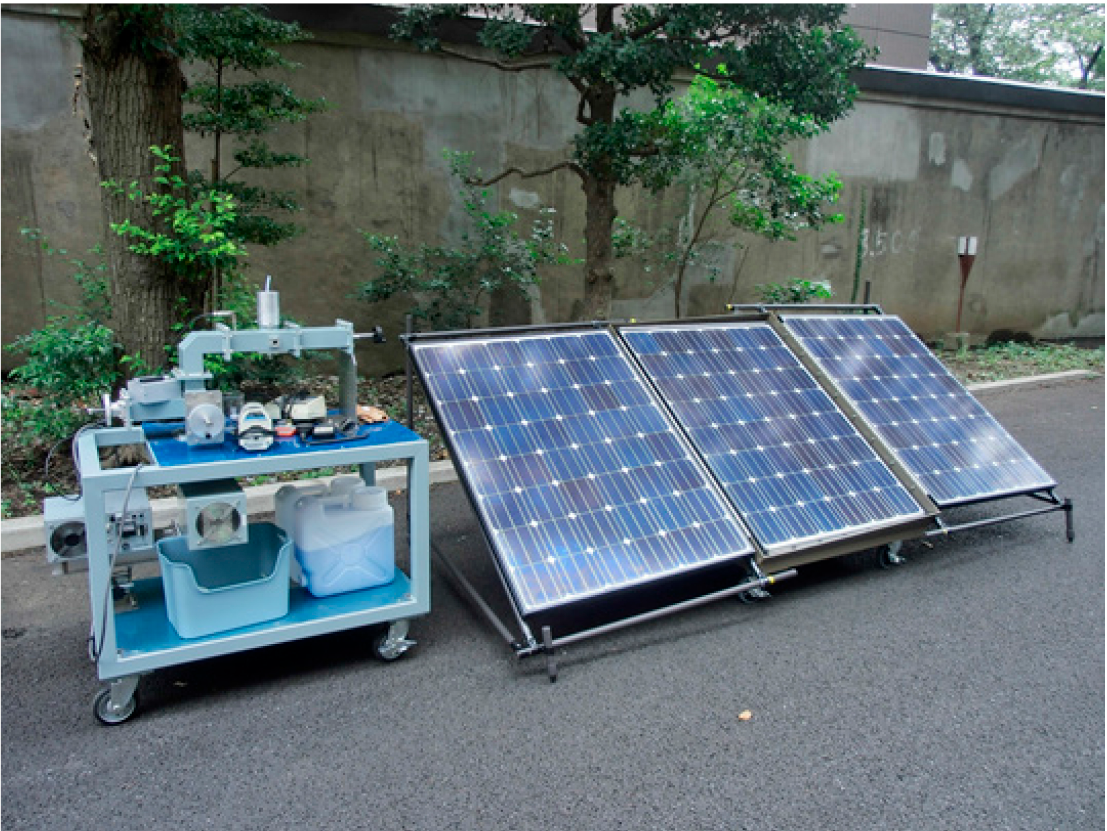
Figure 13. Water sterilization equipment used to sterilize rain water samples using the solar cells located on the right hand side of the photograph and the TiO 2 -coated MDELs (150 pieces)